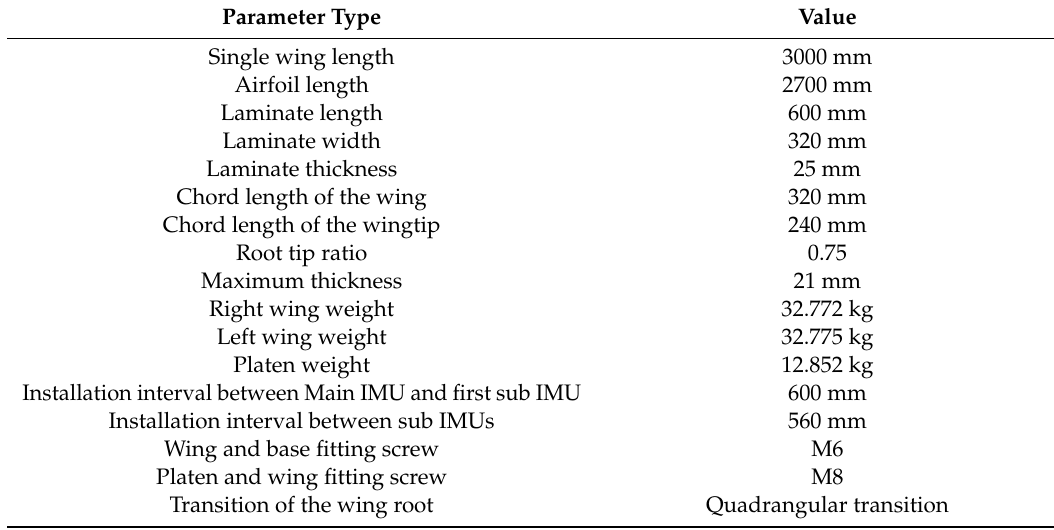
Table 1. Simulation of wing structure